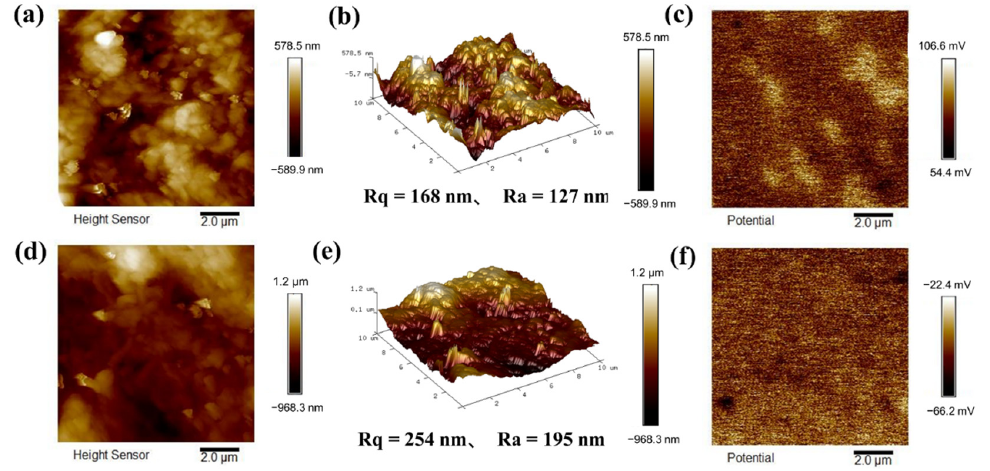
Figure 7. AFM images before and after modification: ( a ) 2D surface topography of paper; ( b ) 3D surface topography of paper; ( c ) surface potential of paper; ( d ) 2D surface topography of PDOTES-paper; ( e ) 3D surface topography of PDOTES-paper; ( f ) surface potential of PDOTES-paper.